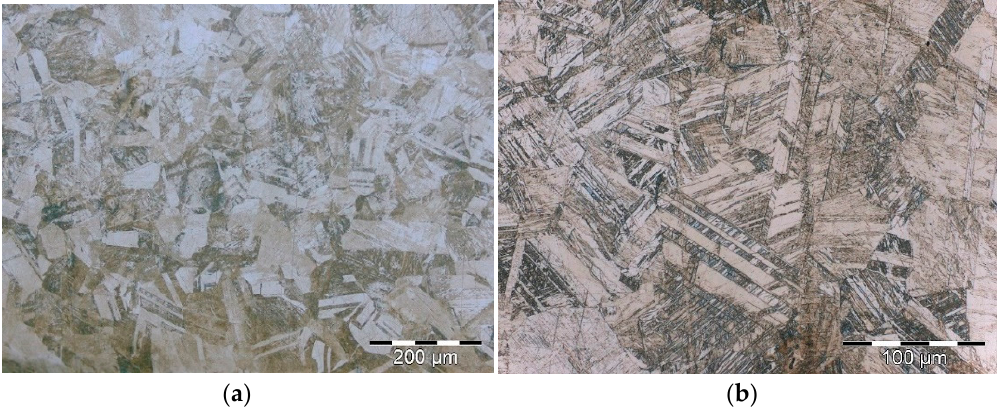
Figure 1. Optical micrographs of the Fe-28Mn-6Si-5Cr alloy at low ( a ) and high ( b ) magnifications.